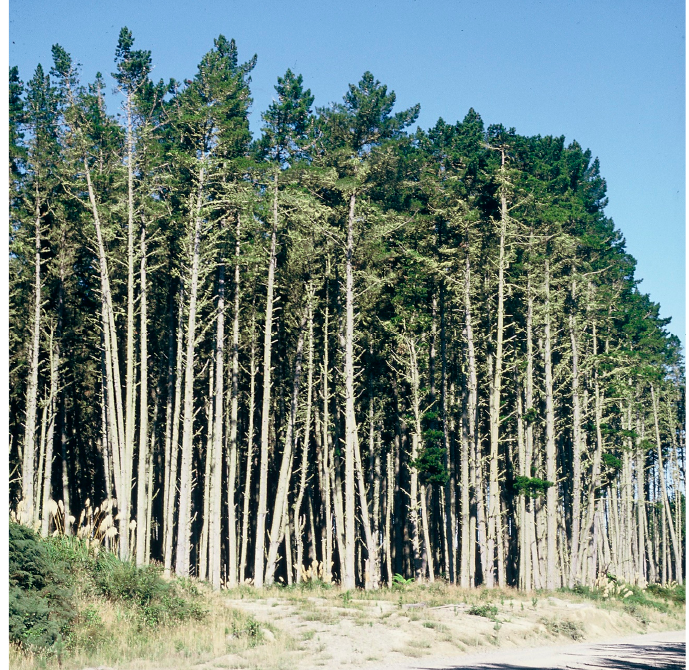
Figure 2. Old stand of P. radiata (>40 years), showing general tree form (Scion Image Library).